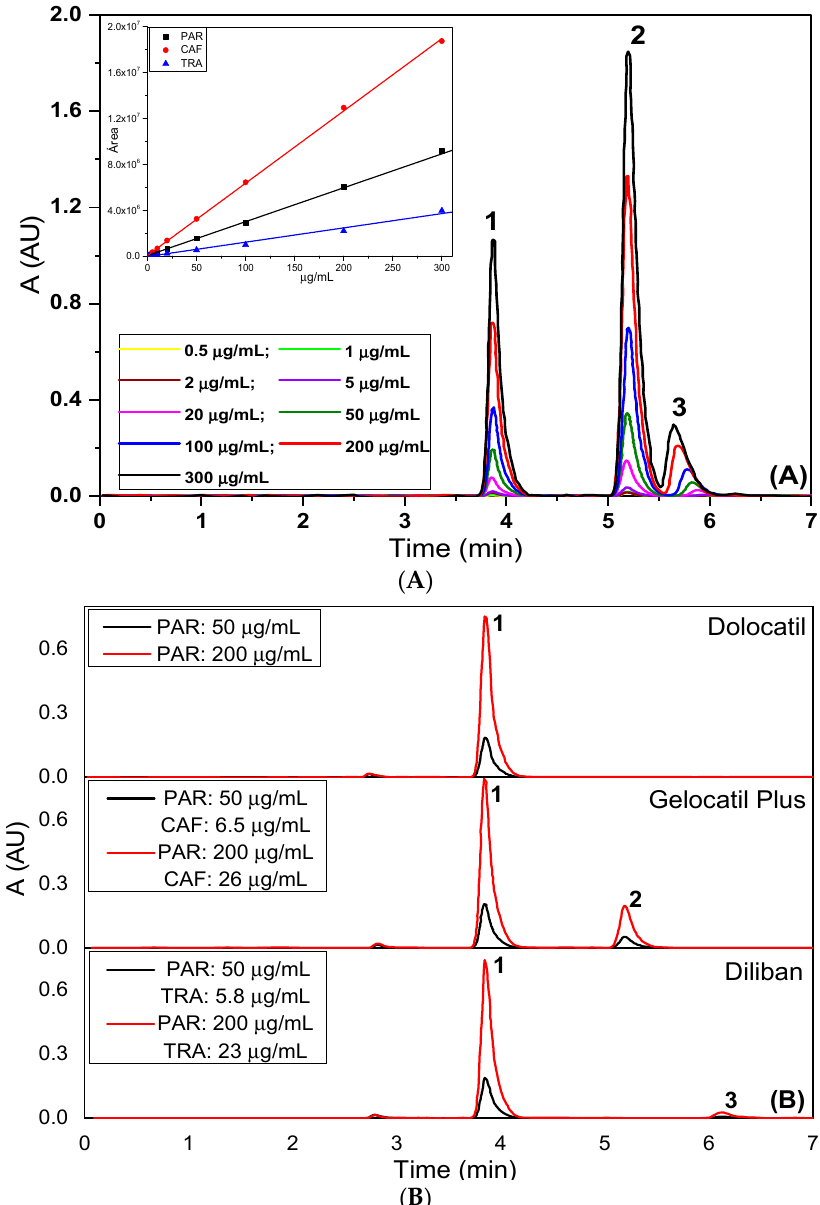
Figure 4. Chromatograms obtained for various concentrations of paracetamol, caffeine and tramadol (peaks 1, 2 and 3, respectively) from ( A ) standard solution and ( B ) real samples. The inset in ( A ) represents the corresponding straight lines.